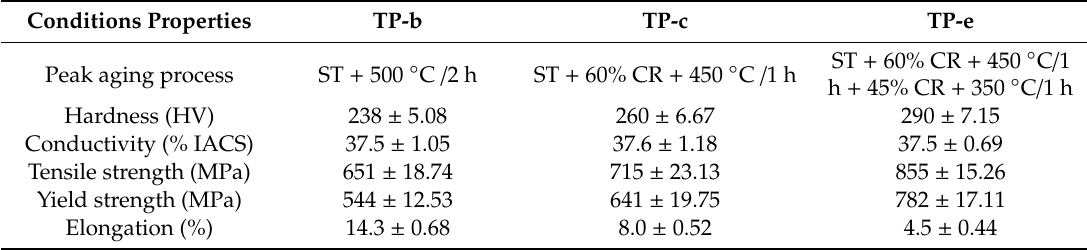
Table 4. Mechanical properties and electrical conductivity of the NS-4 alloy with di ff erent combined heat treatments.